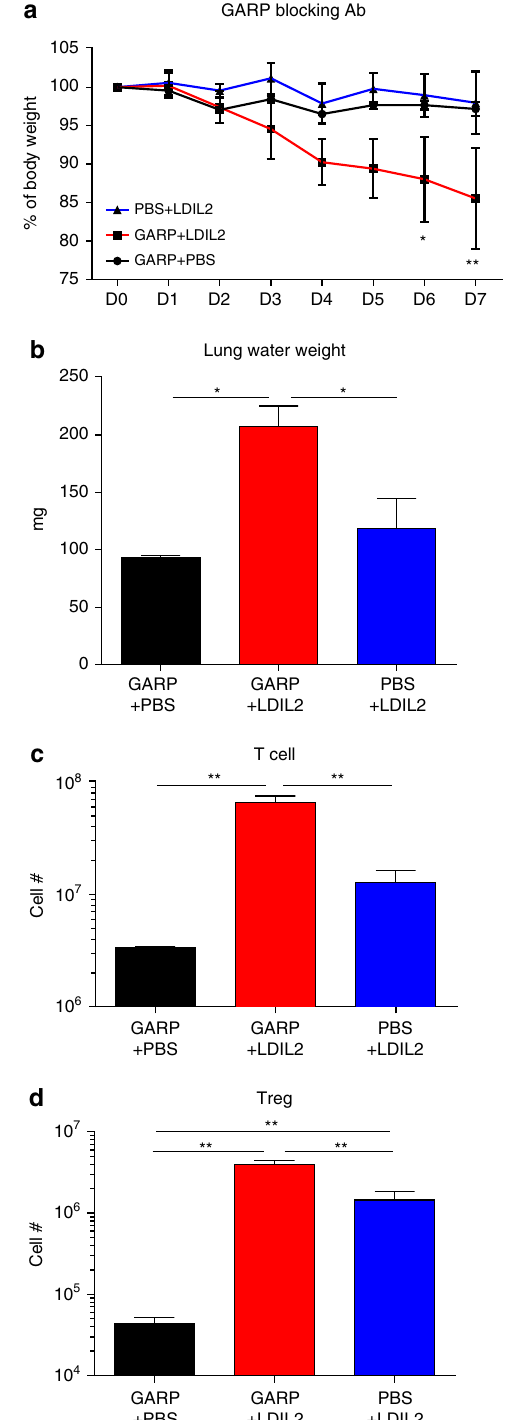
Fig. 6 Blocking regulatory T cell function by anti-GARP mAb in low-dose IL- 2 human immune system mice induces toxicity. 10 − 14-week-old human immune system (HIS) mice were injected i.p. with anti-GARP mAbs 100 μ g daily starting from D0. At D1, 10 μ g IL-2 encoding plasmids were injected hydrodynamically into low-dose IL-2 (LDIL2) treatment group. Mice were killed on D7. a Percentages of body weight change of indicated groups were measured daily ( n = 5 per group). The data are representative of 2 independent experiments. Comparison is between LDIL2 treated HIS mice and other groups by repeated-measures two-way ANOVA with a Sidak test. b Pulmonary edema in HIS mice were measured by lung water weight. c , d Absolute cell counts ± SEM for human CD3 + cells and CD45 + CD3 + CD4 + Foxp3 + cells in spleen of indicated groups. The data are representative of two independent experiments, and analyzed by 1-way ANOVA test with a Tukey test. * P < 0.05, ** P <